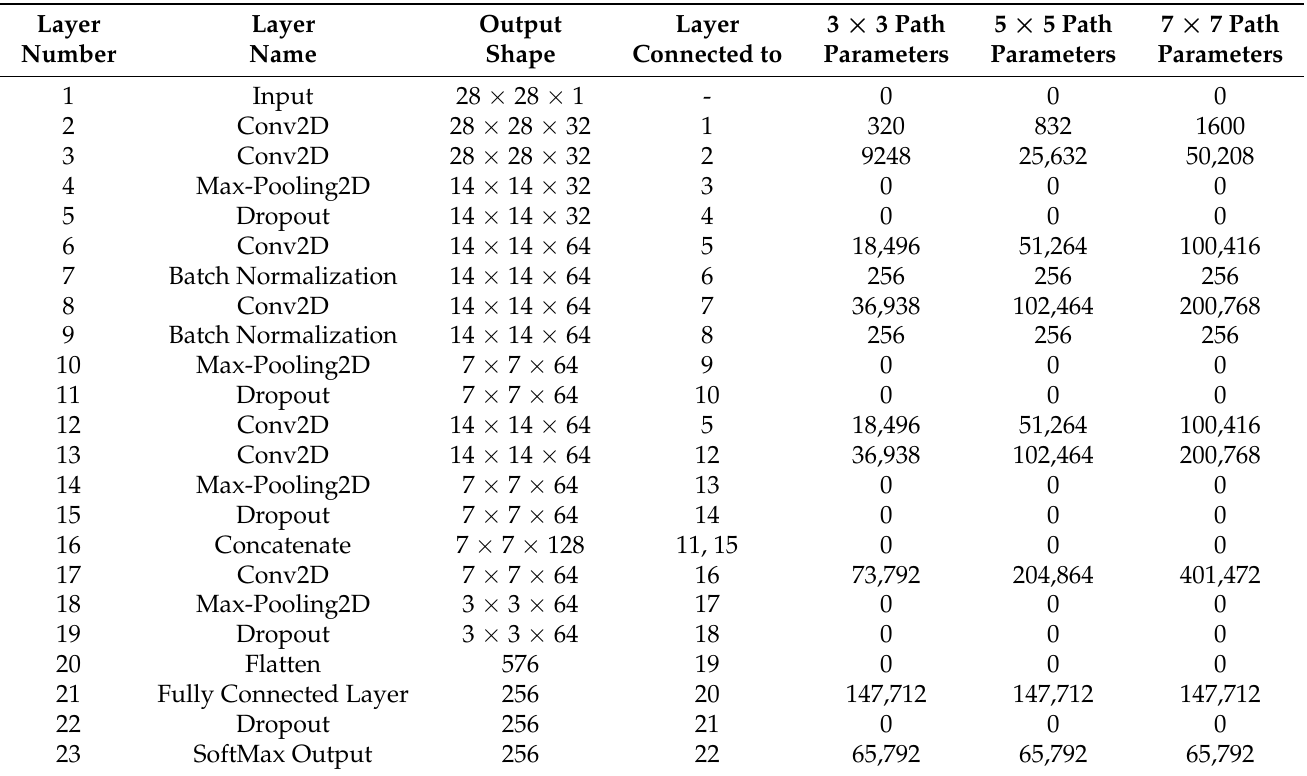
Table 2. Layer description, output shape, and number of parameters for each layer of BengaliNet considering 256 classes.